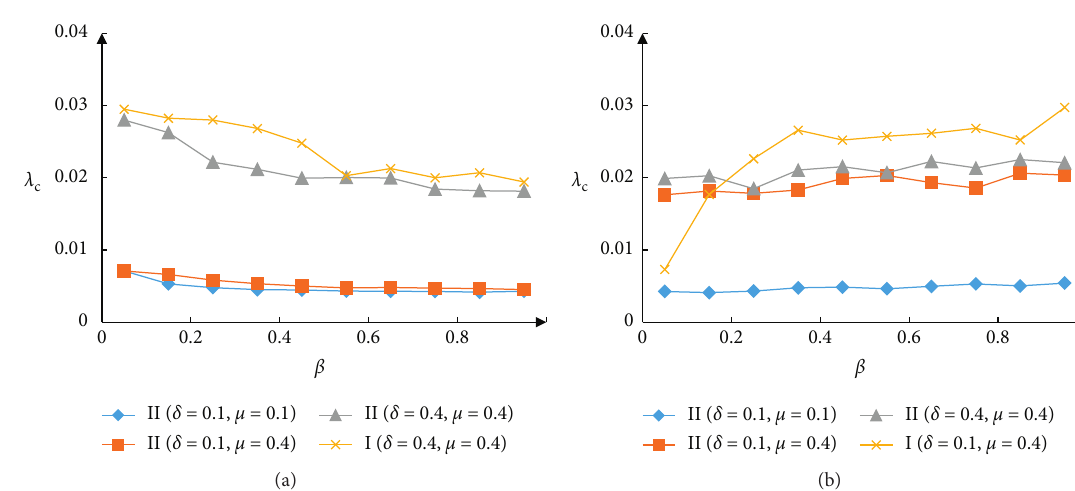
Figure 8: The influence of β on λ